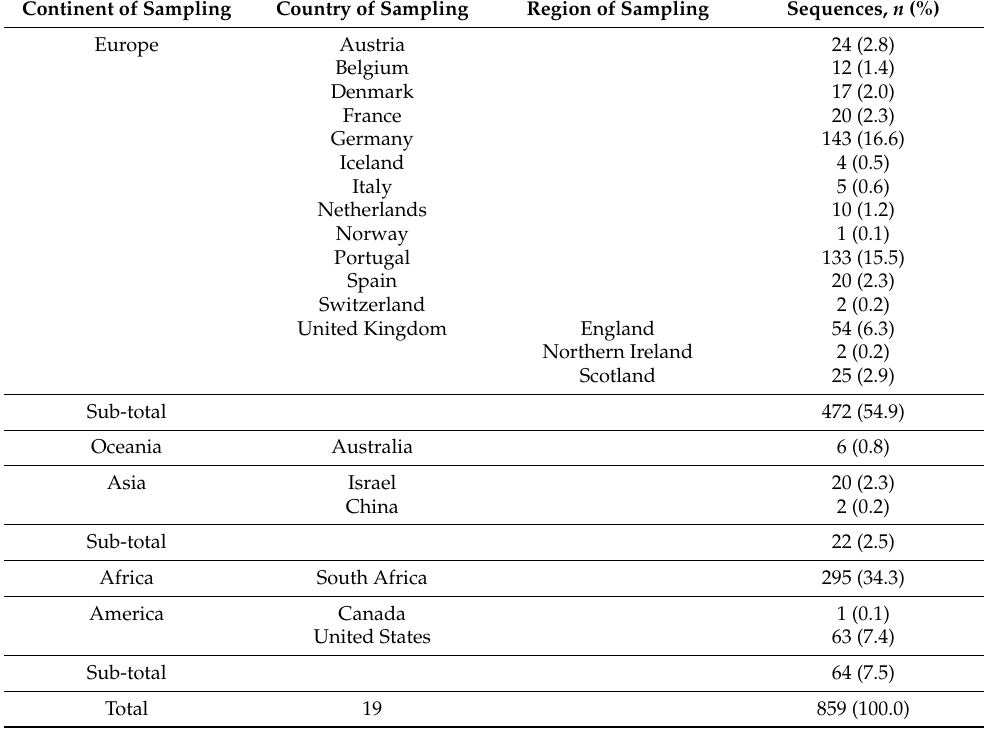
Table 2. Total number of SARS-CoV-2 BA.5 sequences from GISAID database sampled until 10 May 2022, categorized by continent, country, and region of sampling. Sequences of low quality were